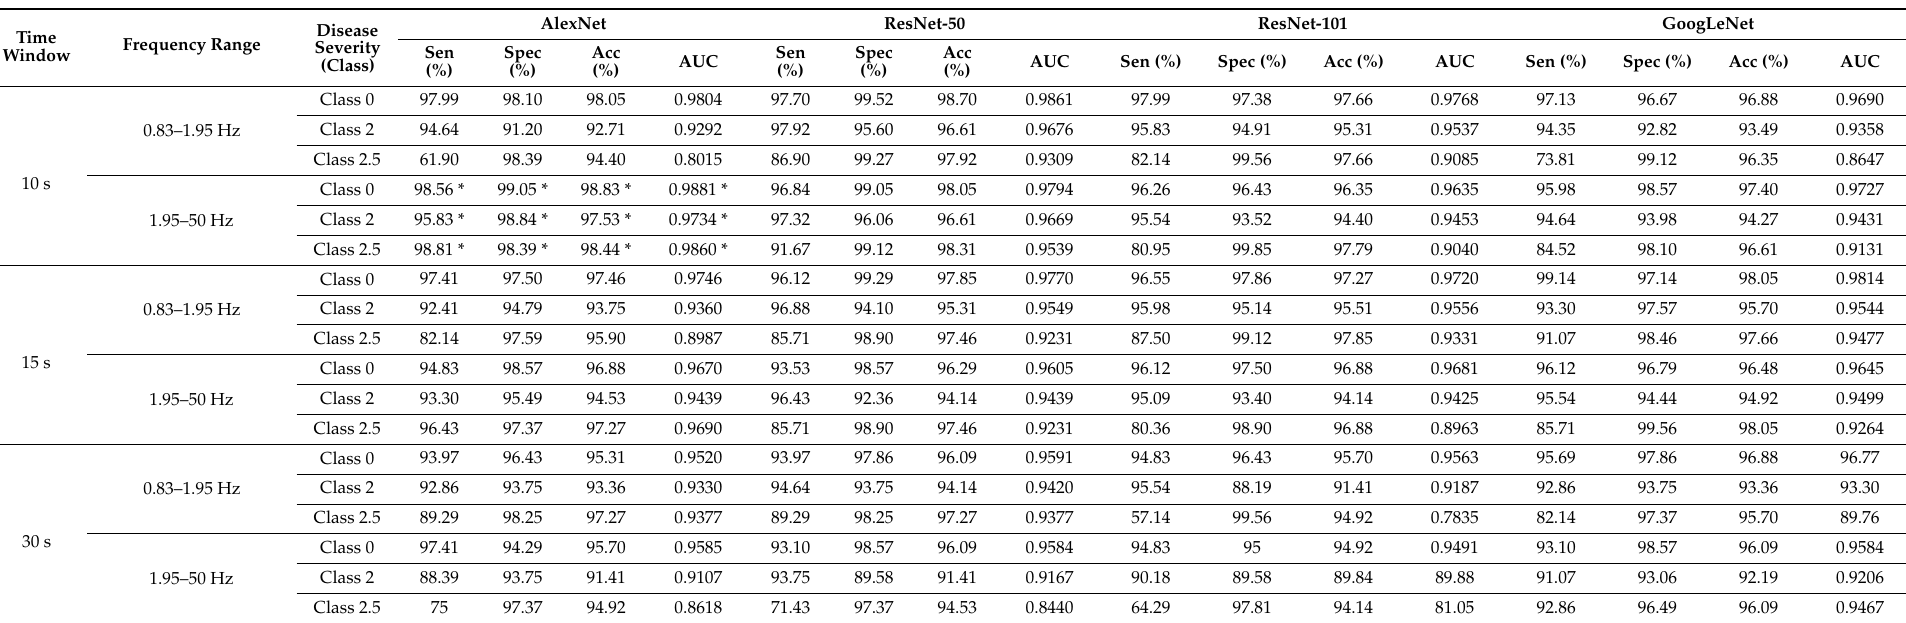
Table 7. Multi-class classification of LF from Si dataset for CO (Class 0), PD Stage 2 (Class 2), PD Stage 2.5 (Class 2.5), and PD Stage 3 (Class 3) using several CNN classifiers (AlexNet, ResNet-50, ResNet-101, and GoogLeNet) with 10-fold